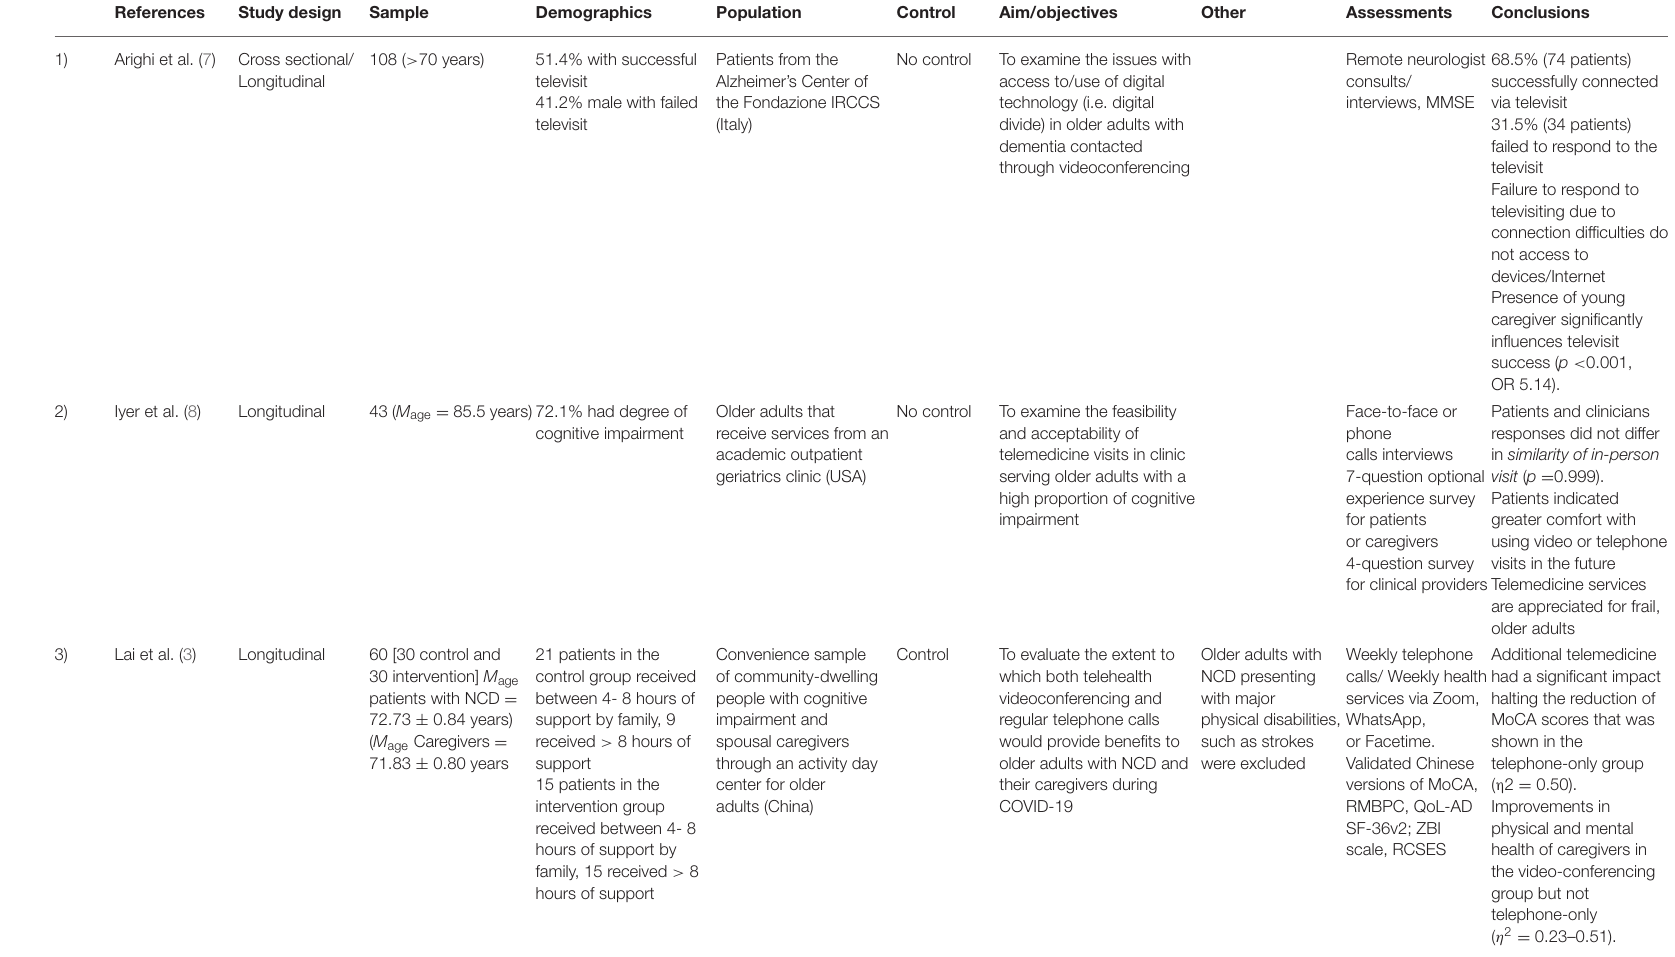
TABLE 1 | Summary of the studies ( n =